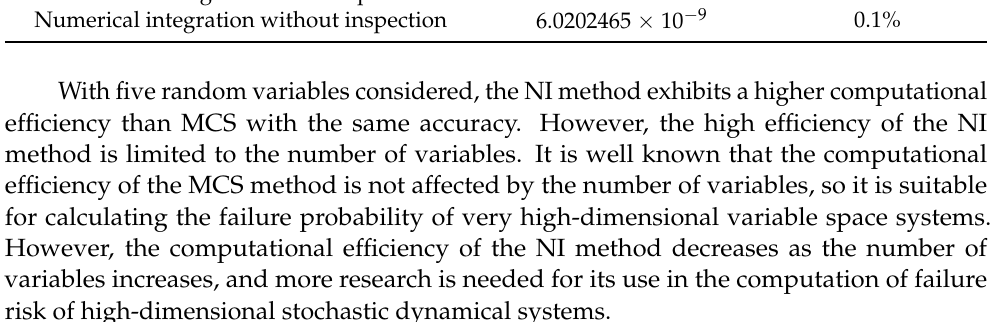
Figure 13. Comparison of the probability of failure of different methods.